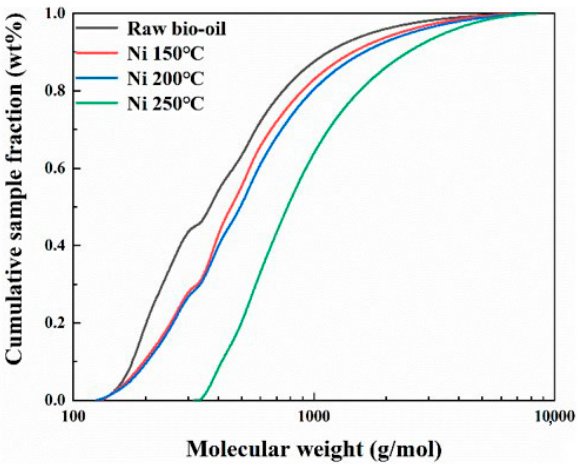
Figure 11. Cumulative molecular weight distribution of bio-oil Pickering emulsion hydrodeoxygenation at 150 °C, 200 °C, and 250 °C.